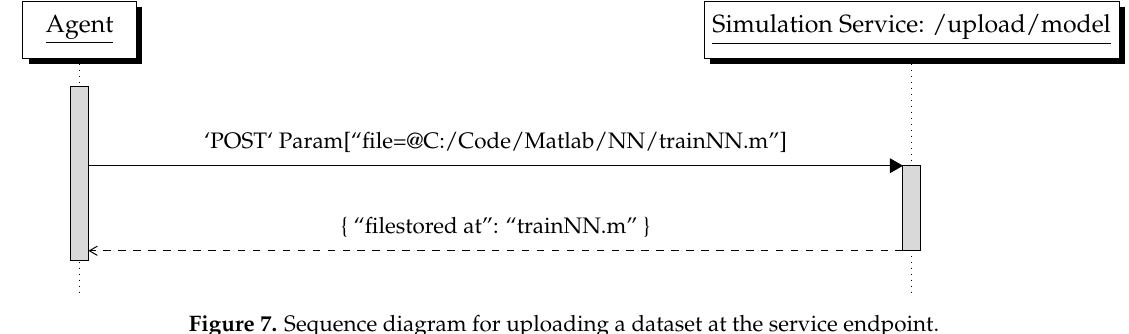
Figure 7. Sequence diagram for uploading a dataset at the service endpoint.